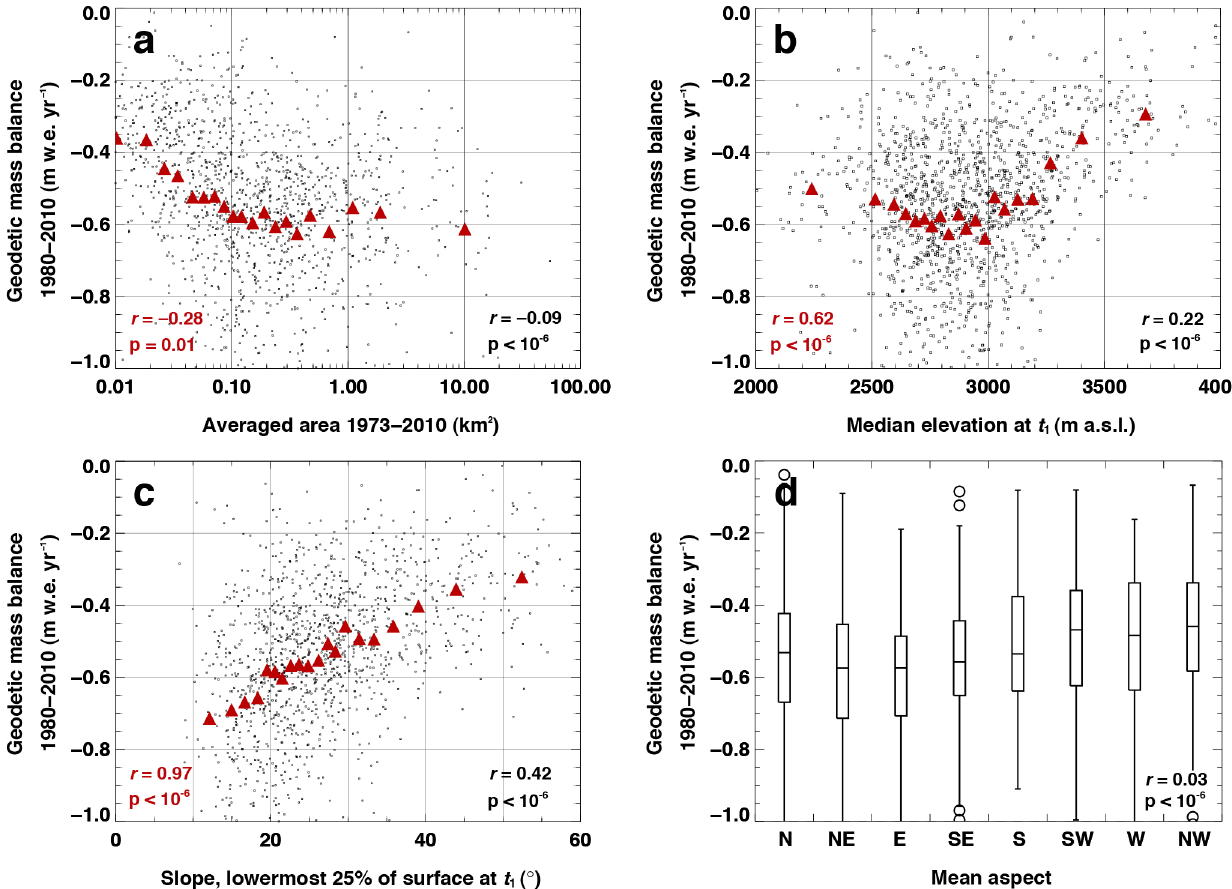
Figure 11. Correlation of temporally homogenized geodetic mass balance 1980–2010 and several geometrical indices. (a) Average area 1973–2010, (b) median elevation at t 1 , (c) surface slope averaged over the lowermost 25% of the glacier and (d) mean aspect, where black boxes enclose the interquartile range (iqr) of the data, defined at iqr75–iqr25, and whiskers extend out to the maximum or minimum value of the data, or to 1.5 times either the iqr75 or iqr25 when there is data beyond this range. Outliers are identified with small circles. Red triangles show mean values for 5% quantiles of the data. r is the linear correlation coefficient and p the significance level of the respective relation (black always refers to the whole data set, while red refers to the mean values for the 5% quantiles